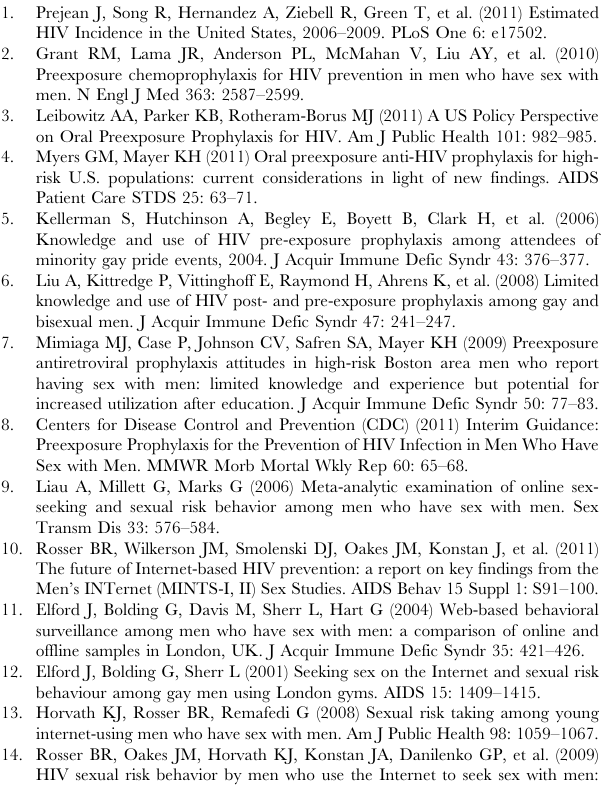
Have Used PrEP Bivariate OR 95% CI P Multivariable OR 95% CI